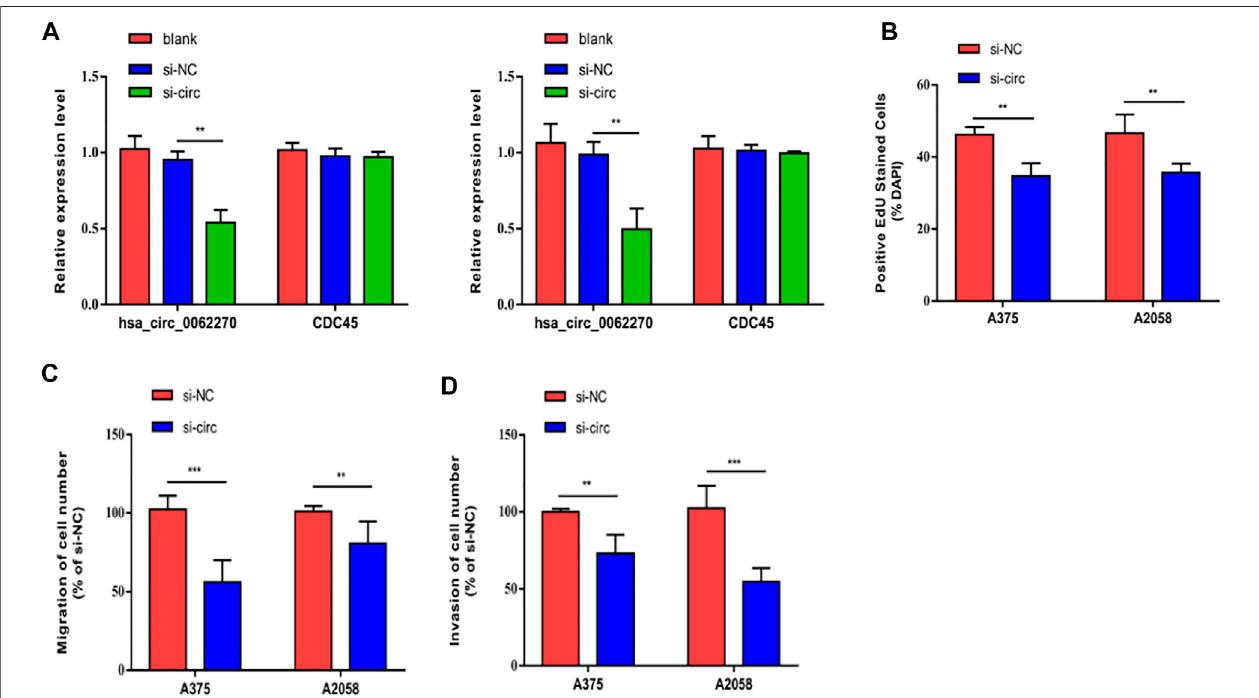
FIGURE 2 | Hsa_circ_0062270 accelerated melanoma to proliferate, migrate and invade. (A) Transfection ef fi cacy of hsa_circ_0062270 siRNA; (B) EdU-positive ratewithhsa_circ_0062270 knockdown; (C) Migrationincellswithhsa_circ_0062270knockdown; (D) Invasion incellswithhsa_circ_0062270knockdown.** p < 0.01; *** p < 0.001.